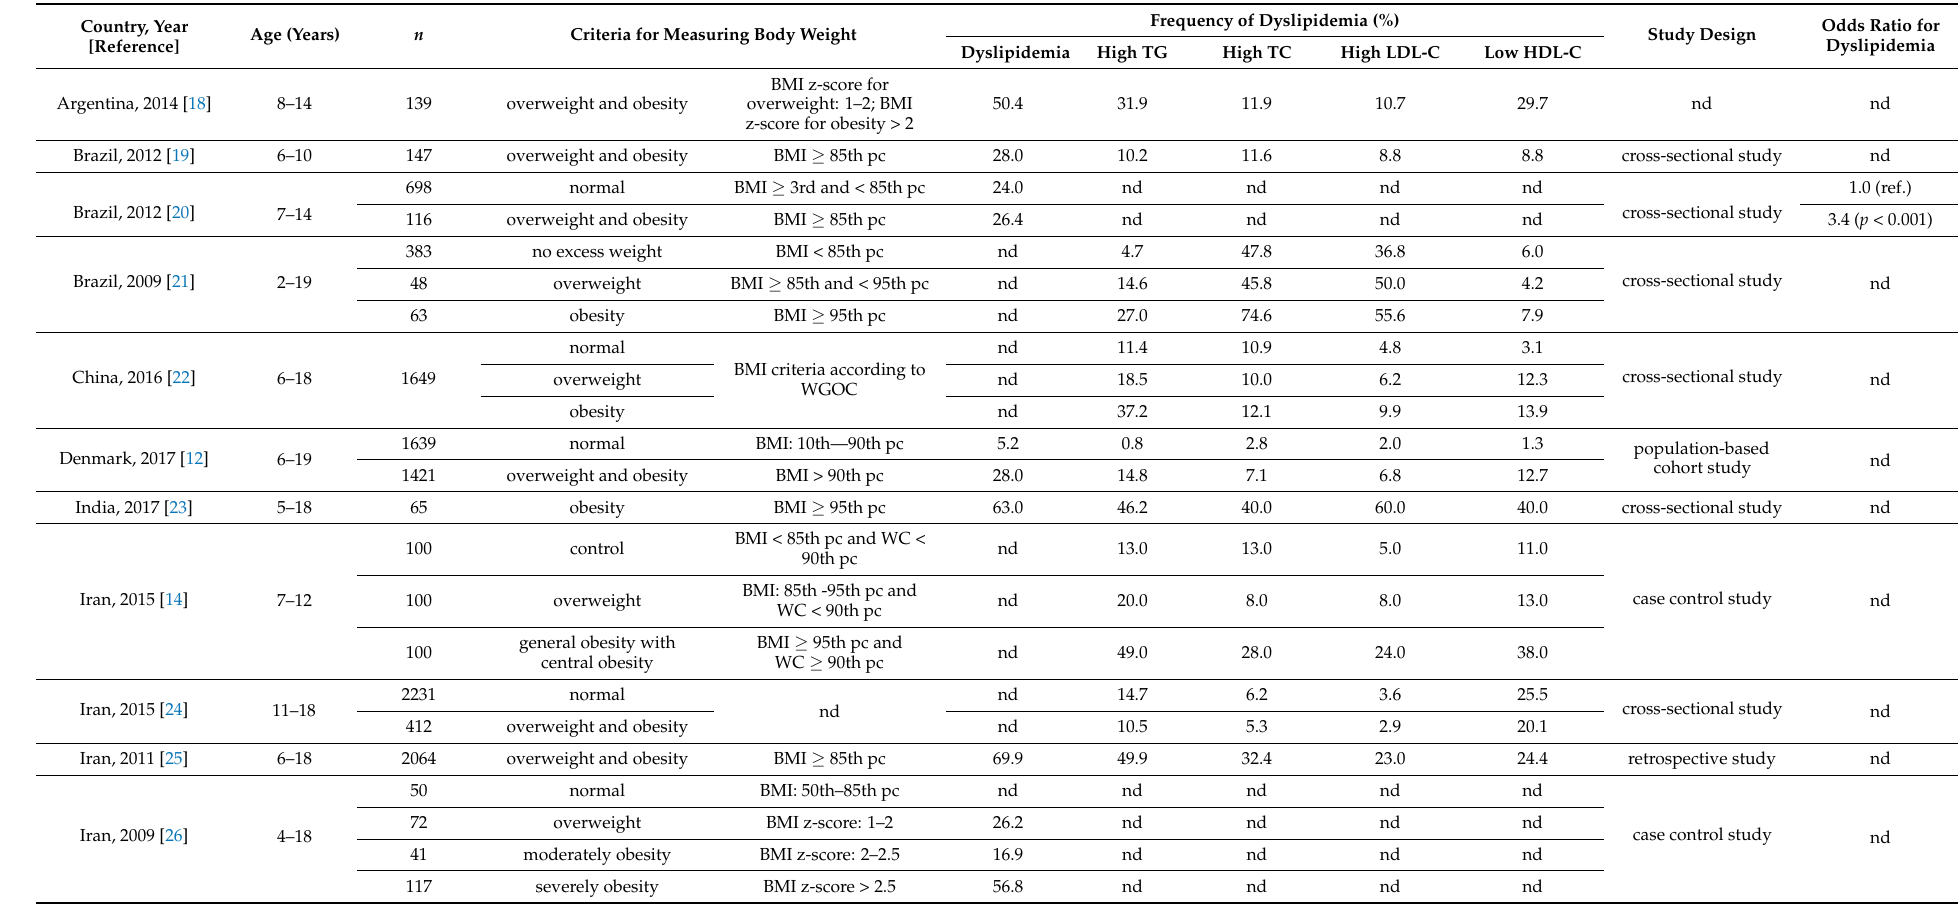
Table 1. Prevalence of dyslipidemia in children and adolescents with normal weight, overweight and obesity (both